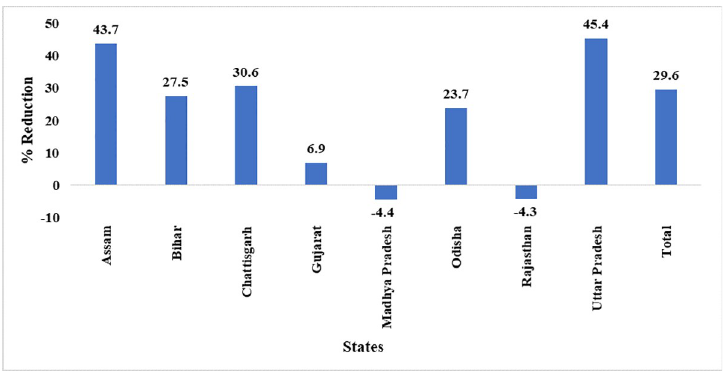
Fig 1. State-wise reduction in vaccine utilization a . a Data of Jharkhand, Manipur, Nagaland and Himachal Pradesh are not presented as the number of CCPs from these states are less than 30.